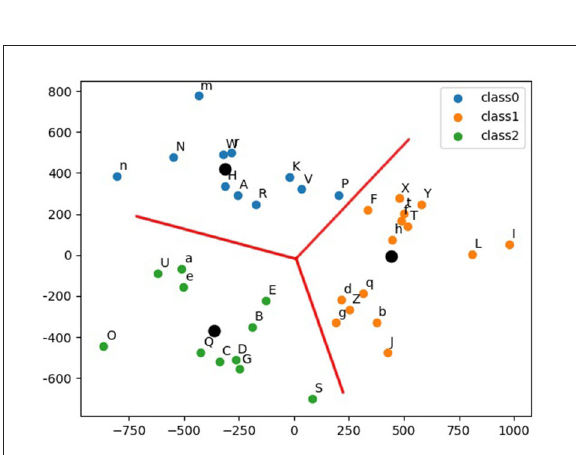
FIGURE11 Thirty-seven English letters are clustered into 3 categories. Black dots represent the center of each